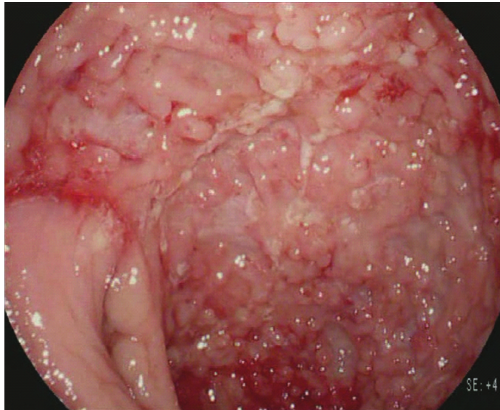
Figure 1: High-definition white-light endoscopy of severe Crohn’s disease with multiple longitudinal ulcers and spontaneous bleeding of the inflamed mucosa.